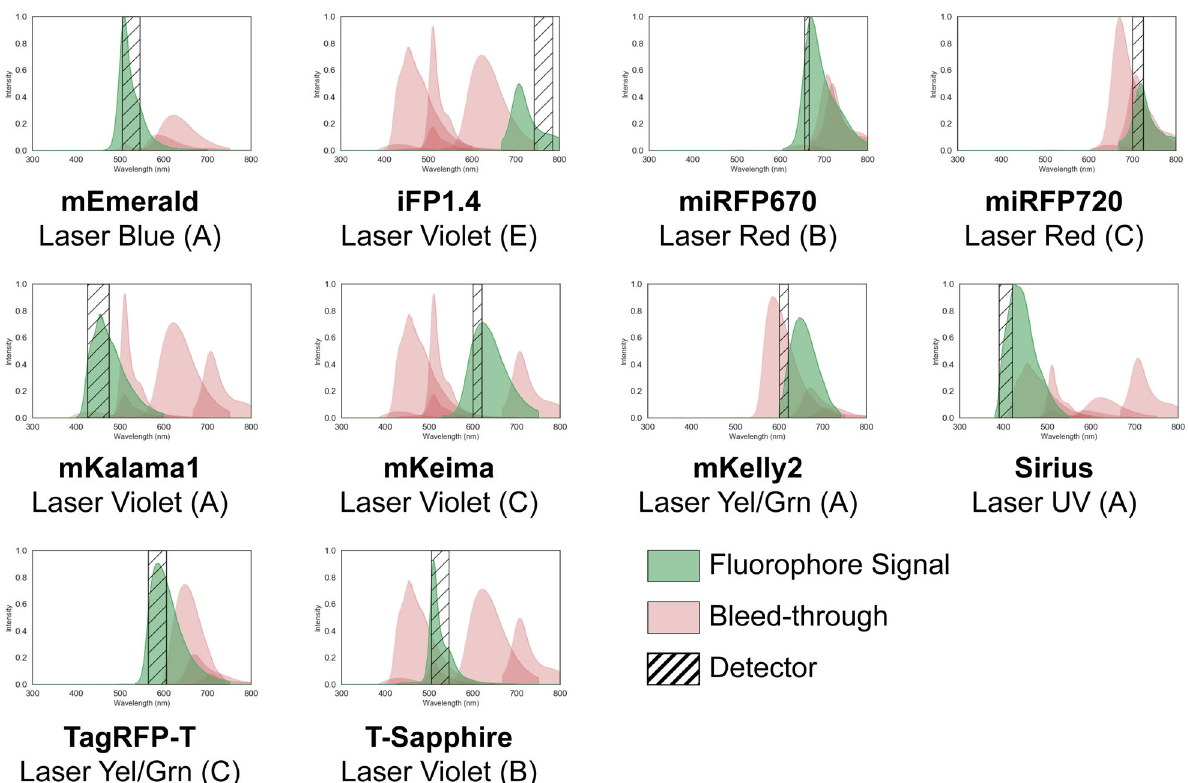
Fig. 4 10-color fl uorophore panel for the CytoFlex LX, selected from a library of 188 fl uorophores obtained from FPbase, after running 5000 iterations of simulated annealing. Out of the 5000 iterations of simulated annealing, this panel con fi guration had the best rank. Due to the enormous size of the solution space, it is computationally intractable to verify the optimality of this 10-color panel. However, this is a valid panel, since each detector has a non- zero amount of signal from the fl uorophore it is intended to